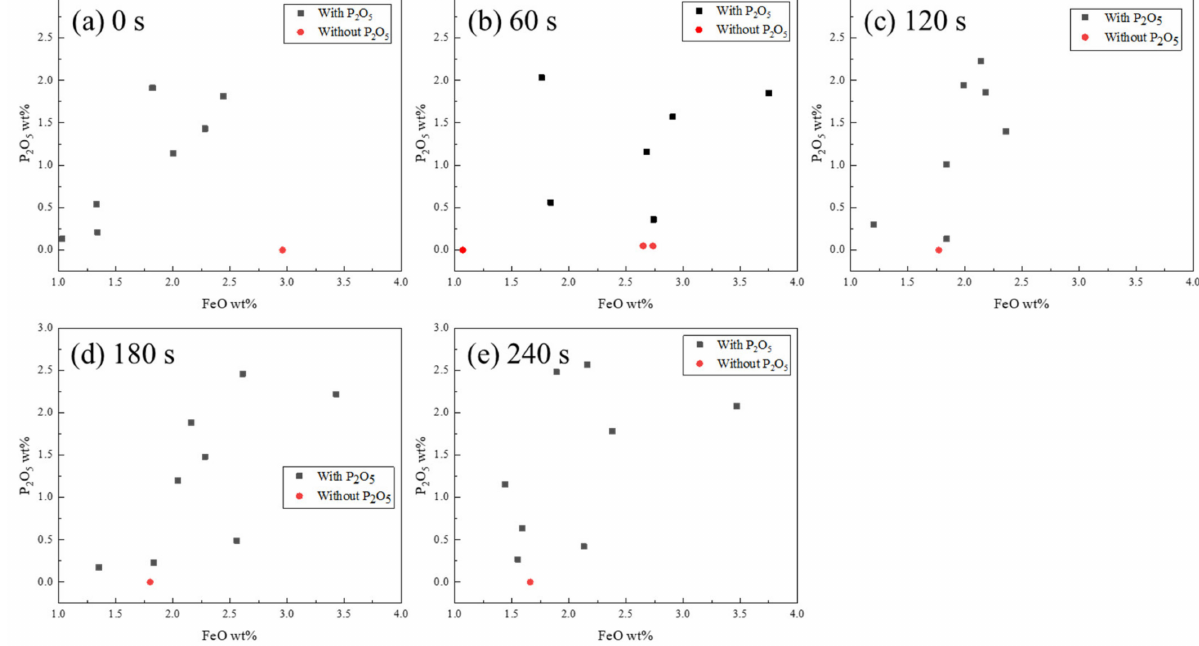
Figure 7. Relationship between the P 2 O 5 and FeO contents in C 2